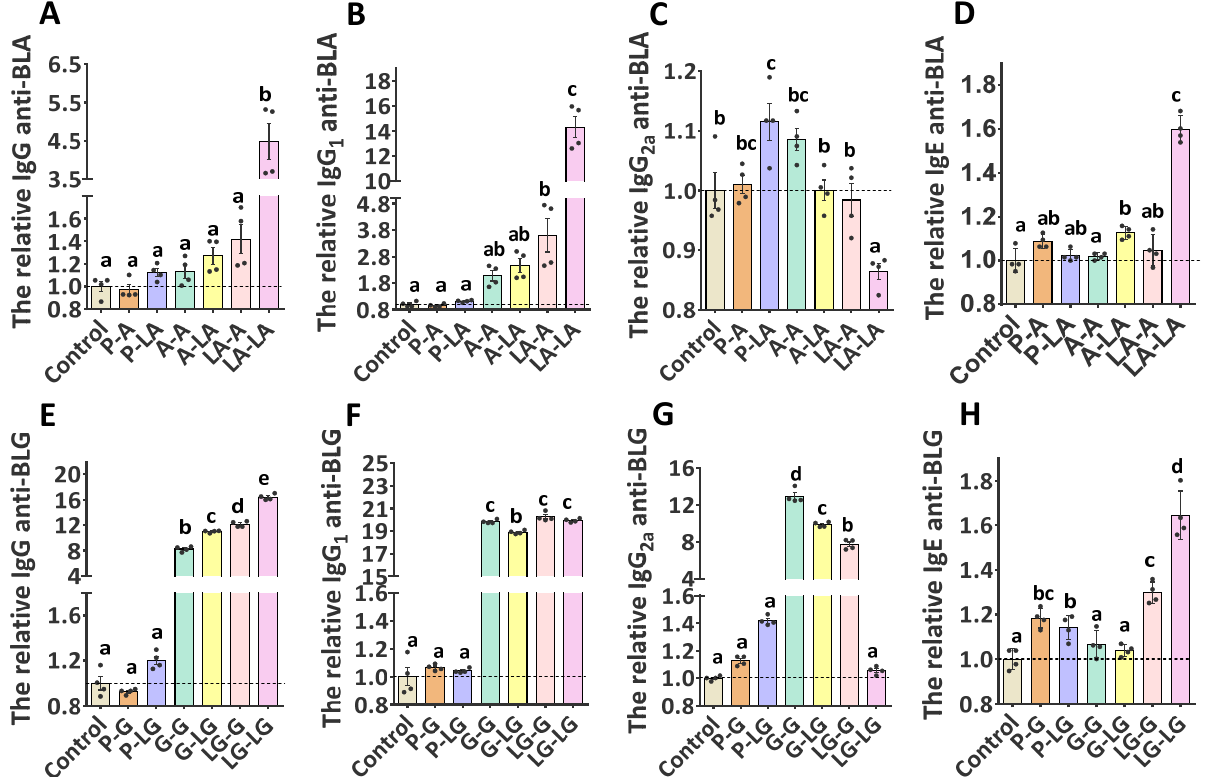
Figure 4. The relative antibodies levels from serum samples of mice determined by direct ELISA: BLA- and BLG-specific IgG ( A , E ), IgG 1 ( B , F ), IgG 2a ( C , G ), and IgE ( D , H ) levels were measured in serum of sensitized and challenged mice with BLA, ALA–BLA, BLG, or ALA–BLG, respectively. Each point represented data from an individual mouse, values were expressed as means ± SEM ( n = 4). The results are representative of two independent experiments. Statistical significance was determined by one-way ANOVA, followed by Tukey’s multiple comparisons test. The groups without the same letter in the histogram bar have statistical differences ( p <